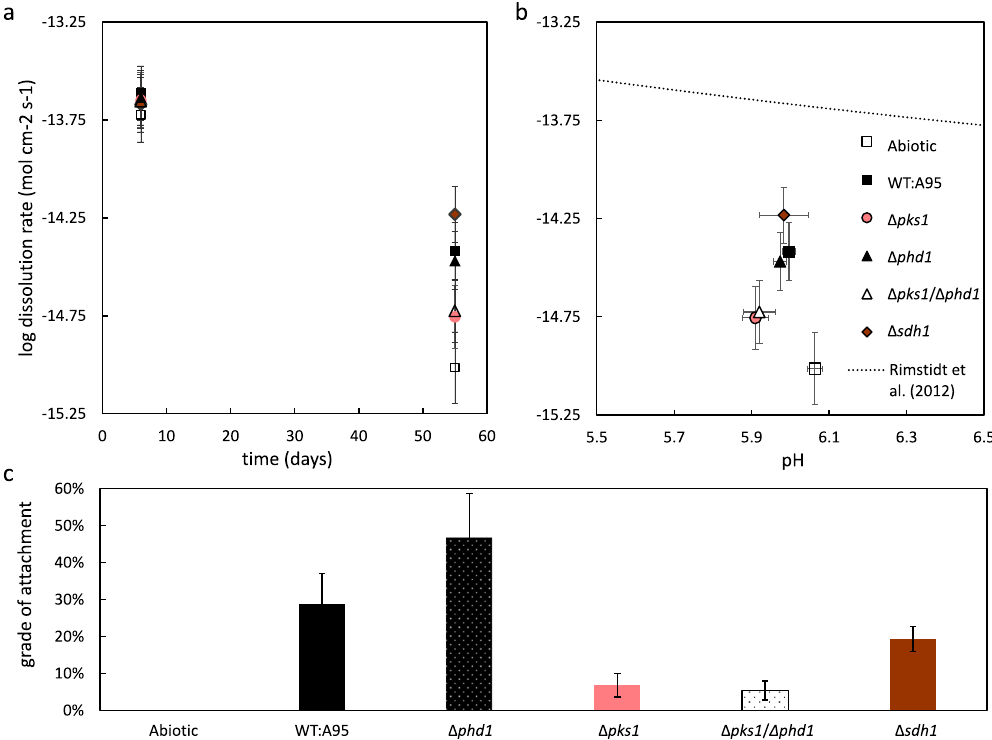
Fig. 4 The dissolution rates as a function of time and pH together with the grades of attachment. a The dissolution rates (mol cm − 2 s − 1 ) were lower at day 55 than at day 6, indicating that olivine dissolution slows down. b The dissolution rates (at day 55) as a function of the pH together with olivine dissolution rate data from the literature (curve calculated using equations reported by Rimstidt et al. (2012)). The dissolution rates from our experiments were lower than those from the literature, again indicating inhibition of dissolution. c The grade of attachment (%) to the olivine for the WT (WT:A95) and mutants of K. petricola at the end of the experiment (i.e., day 69). Whereas the higher grade of attachment seems to explain the higher olivine dissolution rates for the WT and Δ phd1 mutant compared to the Δ pks1 and Δ pks1 / Δ phd1 mutants, this is not the case for the Δ sdh1 mutant. Error bars represent twice the standard error of the three biological replicates or twice the (propagated) analytical uncertainty, whichever was